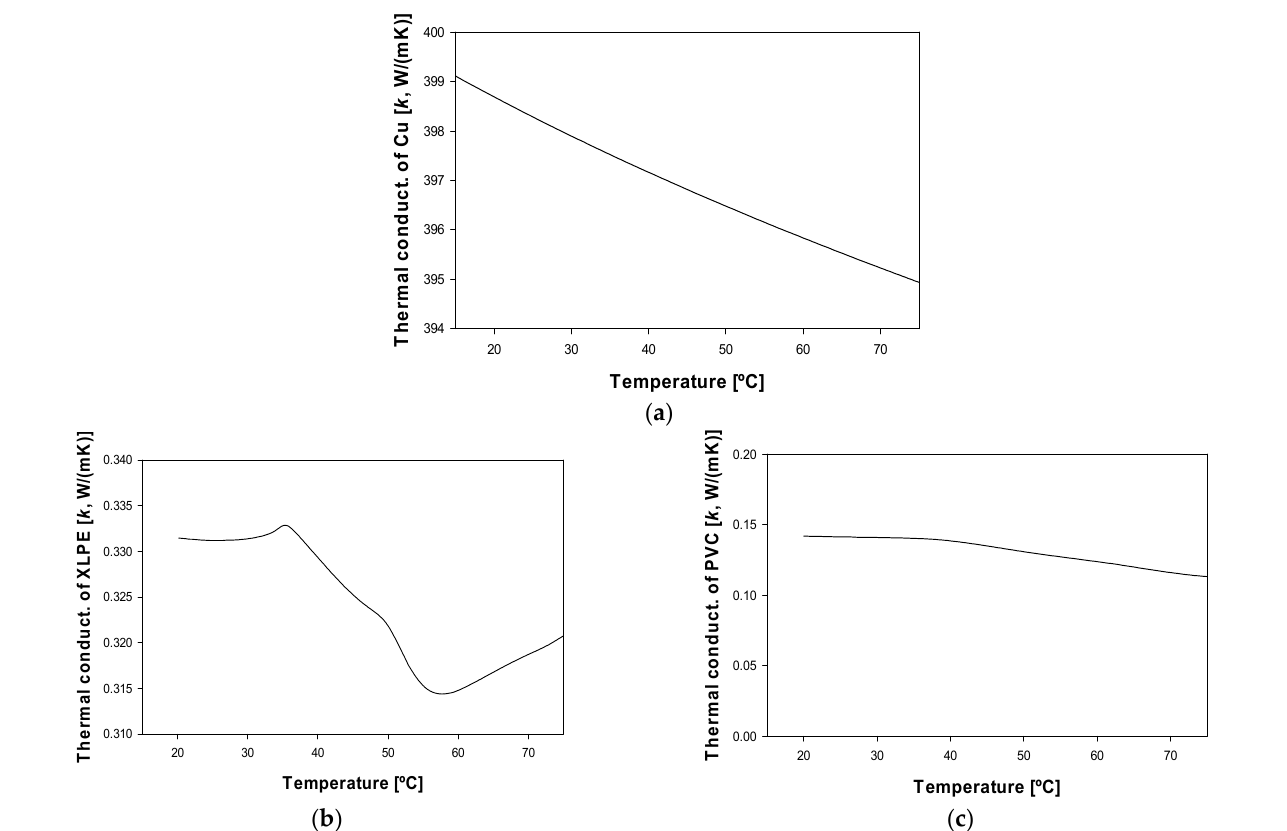
Figure 3. Temperature evolution of the thermal conductivity k of the different cable materials: ( a ) Copper [31]. ( b ) XLPE [32]. ( c ) PVC [33].